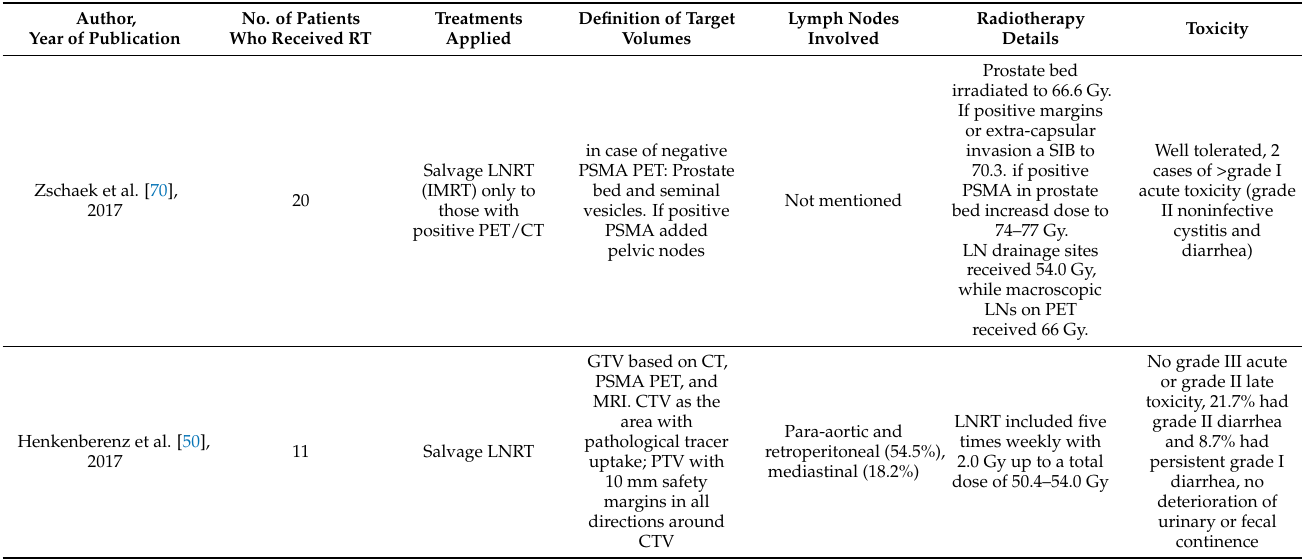
Table 3. The details of radiotherapy target volume, dose and toxicity in studies that used radiotherapy for the treatment of prostate cancer recurrence based on PSMA PET/CT